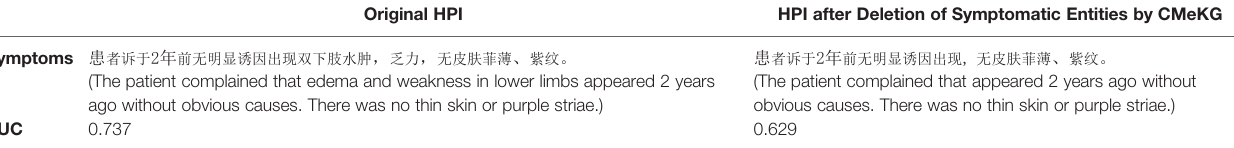
TABLE 5 | Example of Occlusion Test